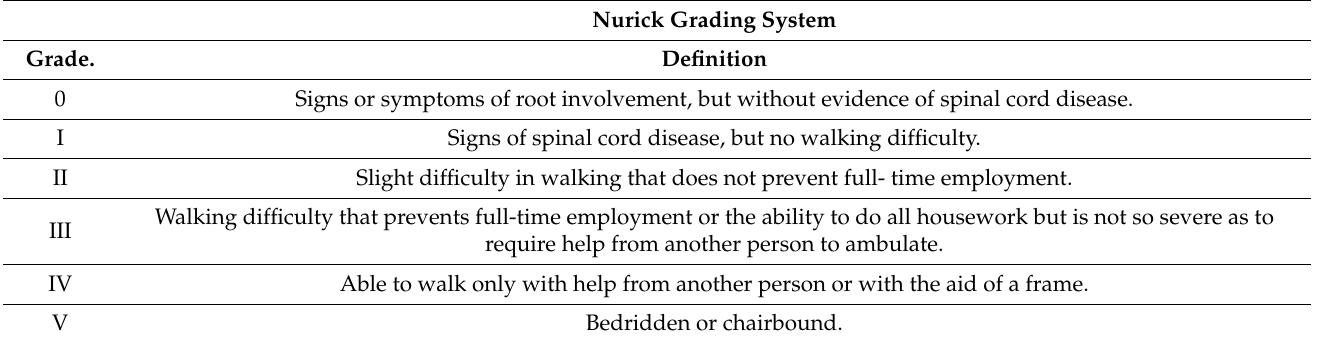
Table A5. Nurick Grading System